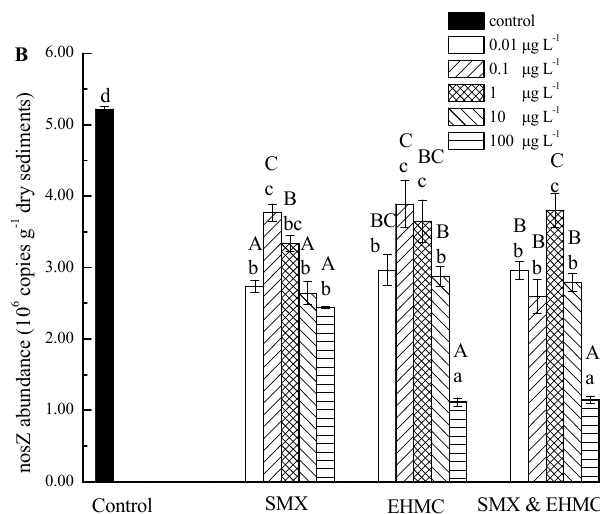
Figure 5. The e ff ects of SMX and EHMC on nirS ( A ) and nosZ ( B ) genes. The values are the means and the error bars represent the standard deviations (n = 3). The treatment groups sharing di ff erent lowercase letters represent significant di ff erences ( p < 0.05). The uppercase letters indicate significant di ff erences between concentrations in the same treatment ( p < 0.05).